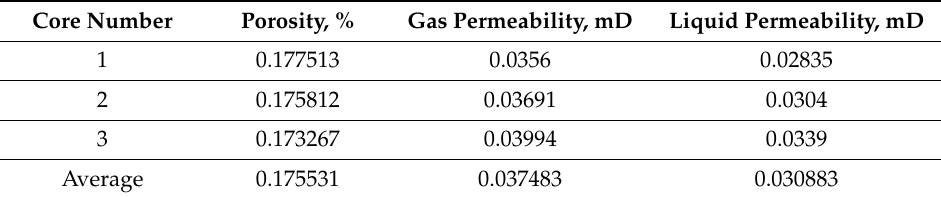
Table 1. Experimental core